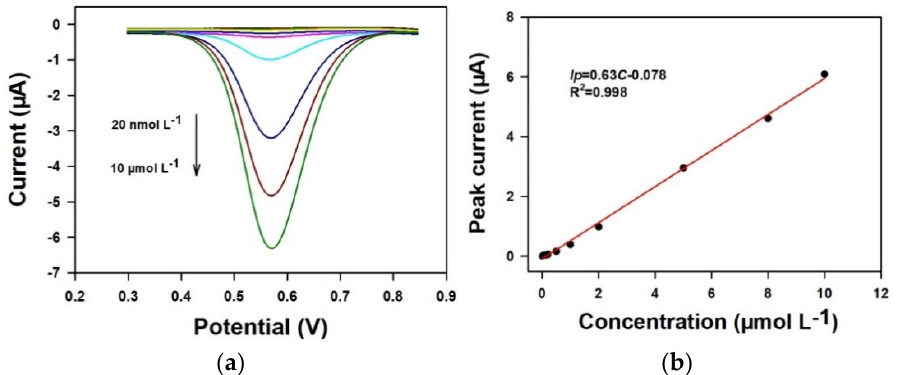
Figure 5. Differential pulse voltammograms ( a ) obtained on BiMRs/GCE in 0.05 mol L − 1 HCl solution with successive addition of 0.02, 0.05, 0.1, 0.2, 0.5, 1, 2, 5, 8 and 10 μ mol L − 1 Fe 3+ and the corresponding calibration curve ( b ). Table 1. Comparison of the determination results with the values of the environmental standard samples ( n = 3).